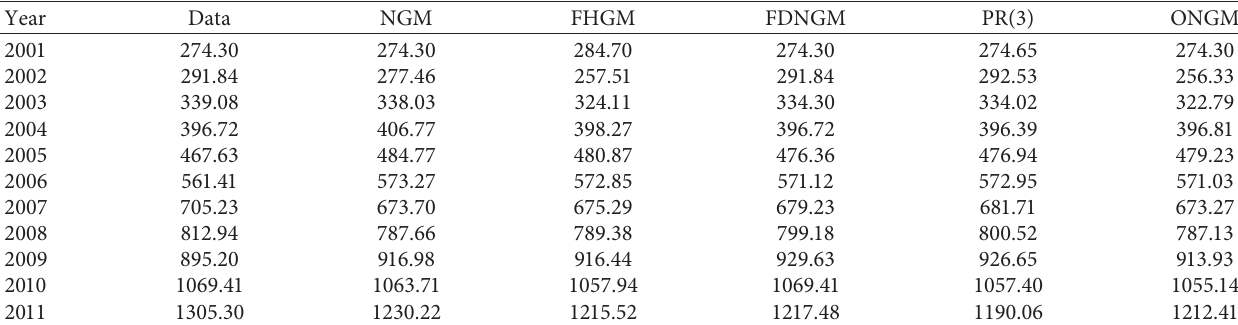
Figure 4: Searching process of the WOA-based FDNGM(1,1, k , c ) model in Case 2. Table 5: The predicted values of original domain by employing the competing models in Case